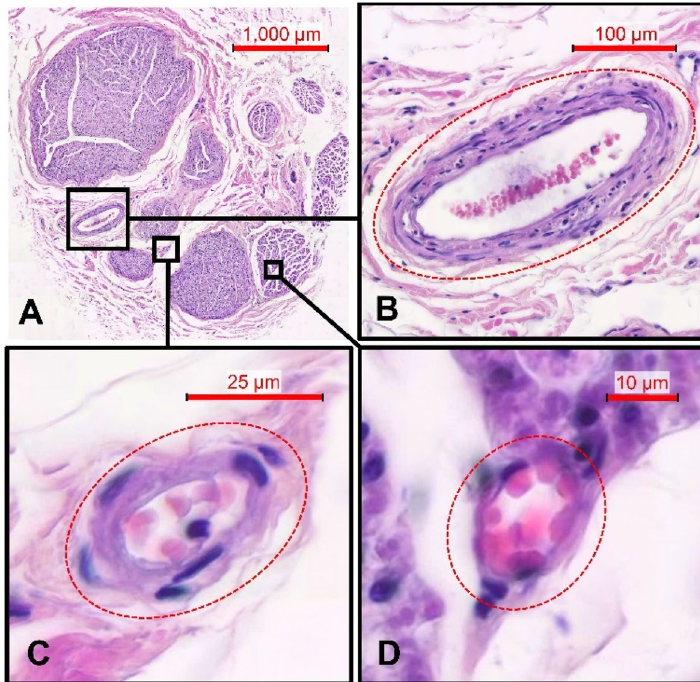
Figure 2. Histology sample of the cervical vagus nerve stained with hematoxylin–eosin. Nerve fascicles surrounded by perineurium and epineurium can be seen ( A ). Vascular supply with the “vagal artery” laying external to the epineurium (B) , subperineural vessels within the perineurium ( C ), and minor vessels within the axon tissue within the nerve’s fascicles ( D ) are shown. Pictures of ( B – D ) are magnifications of ( A ) in given resolution.